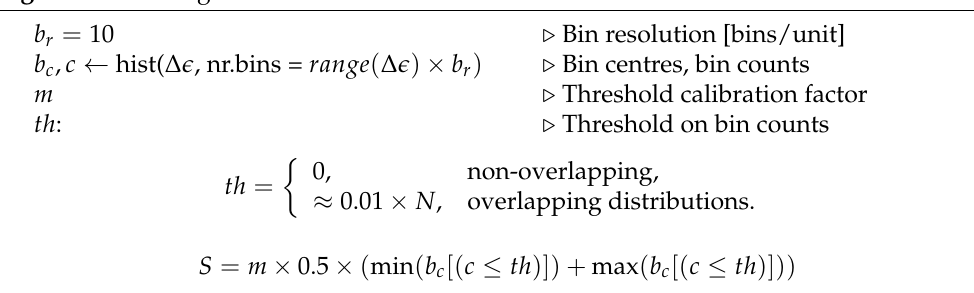
Algorithm 1 Histogram based threshold selection.